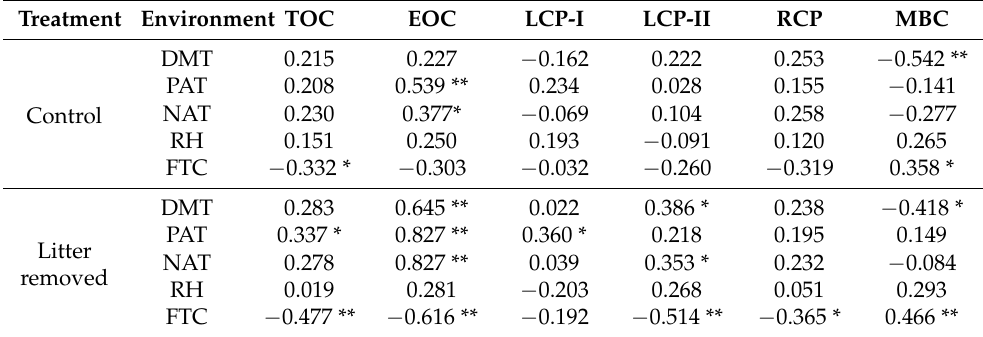
Figure 3. Concentrations of soil microbial biomass C of three forests at different sampling periods. Values indicate means ± standard error, n = 3. Asterisks indicate significant differences between the two treatments in the same forest type at the same season. * p < 0.05, ** p < 0.01. GS: growing season, EFS: early freezing season, FS: freezing season, TS: thawing season.